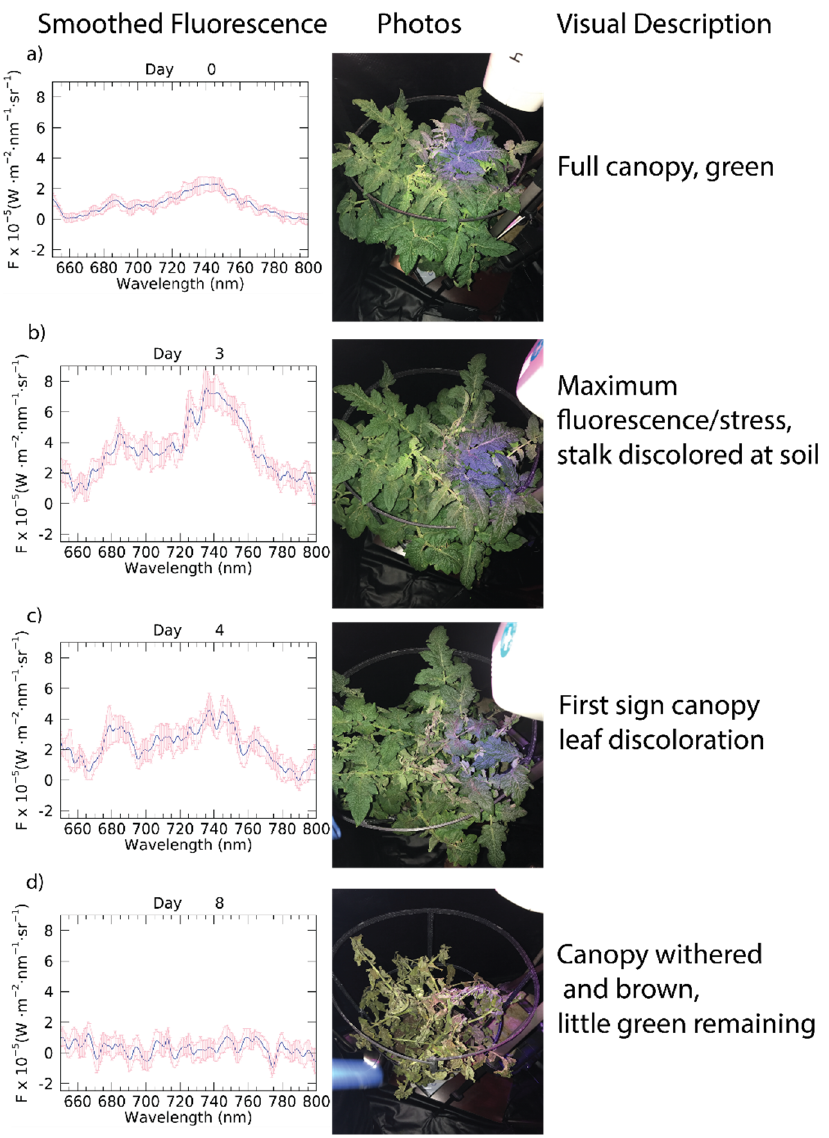
Figure 2. CF spectra, images and descriptions of selected days of experiment: ( a ) Day 0, ( b ) Day 3, ( c ) Day 4, ( d ) Day 8. Left column: Daily average smoothed fluorescence (F sm ), blue lines indicate F sm spectra, shaded pink region indicates standard deviation for the day. Middle column: photographs of tomato plant each day. Right column: description of visual inspection of plant for each day. Daily fluorescence spectra, pictures and visual descriptions are included in Appendix A.